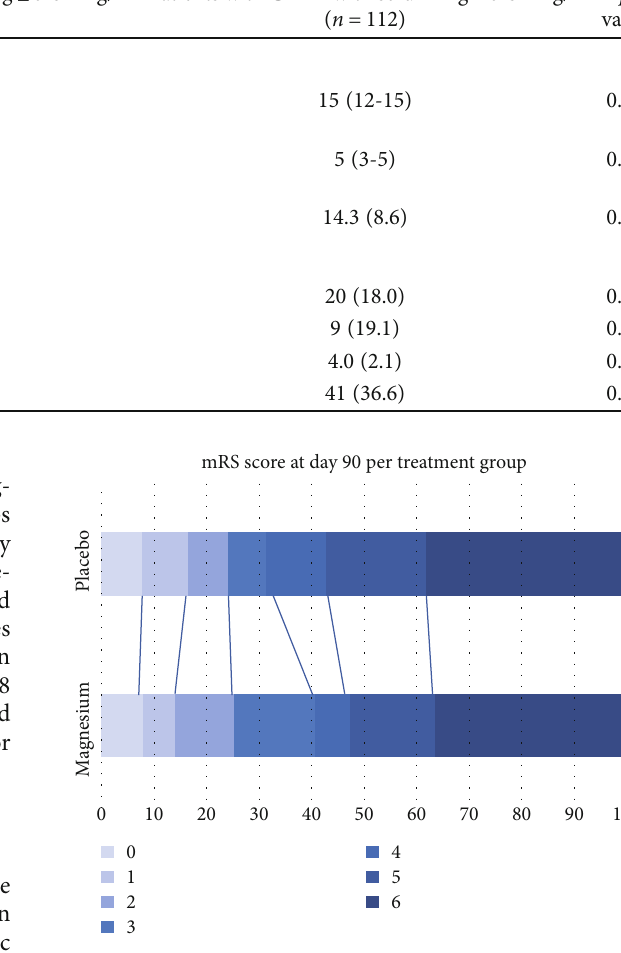
Figure 1: Functional outcomes at 90 days in the magnesium and placebo groups of patients with CAEs, according to score on the Modi fi ed Rankin